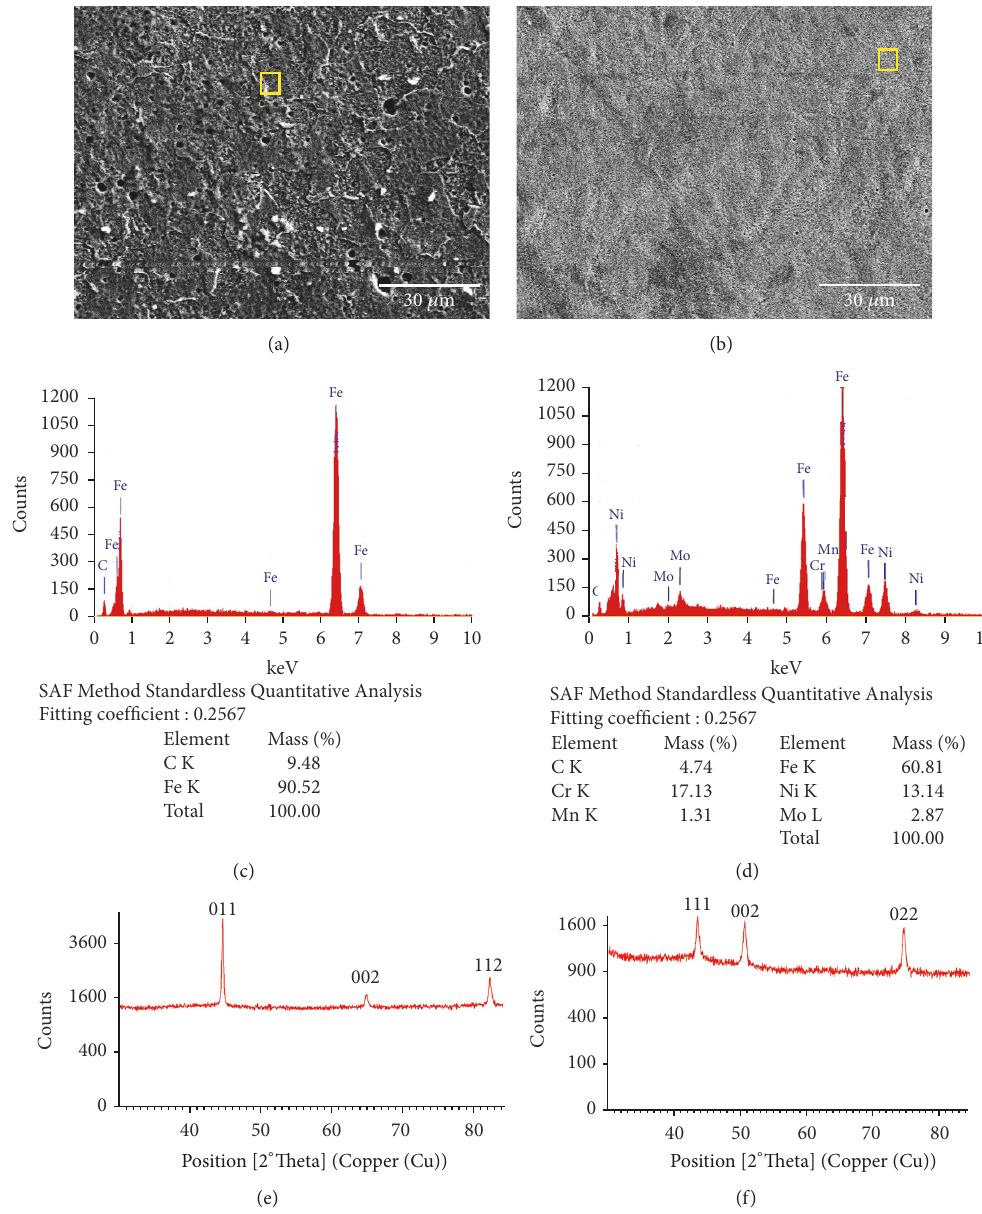
Figure 1: Surface scanning electron microscopy micrographs of sample (a) overview of iron-based implant, (b) overview of stainless steel implant (1000x mag), (c) EDS spectra of iron-based, and (d) EDS spectra of stainless steel, (e) X-ray diffraction of iron-based, and (f) X-ray diffraction of stainless steel